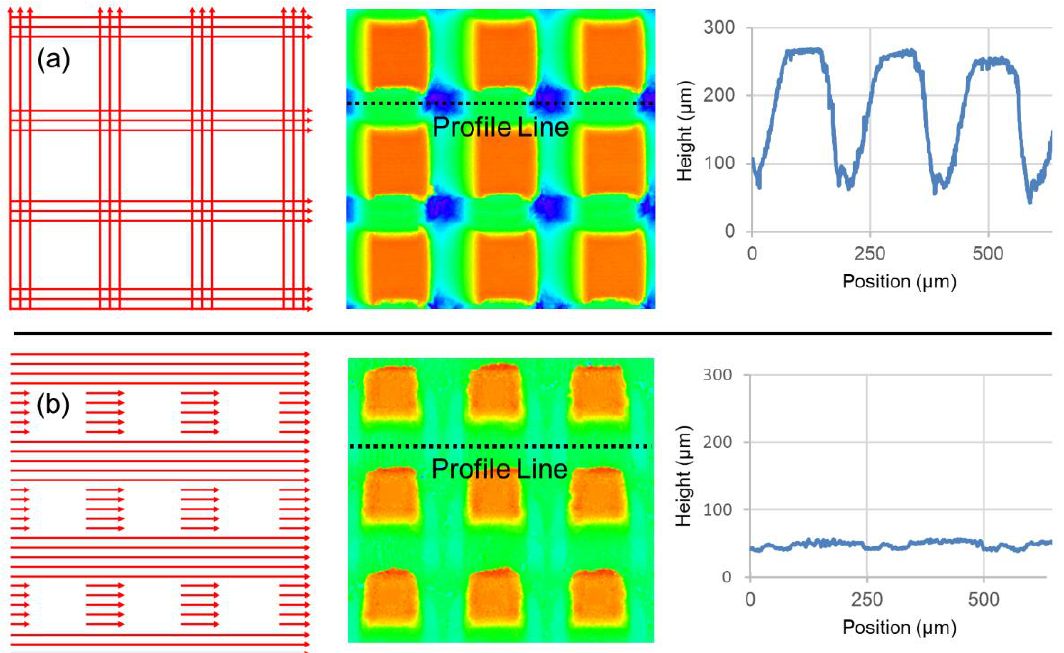
Figure 1. Comparison of square pillar microstructures fabricated using a simple grid pattern without a shutter ( a ) and the same structures fabricated using a sophisticated shutter system, allowing for greater control of the accumulated ablation depth ( b ).